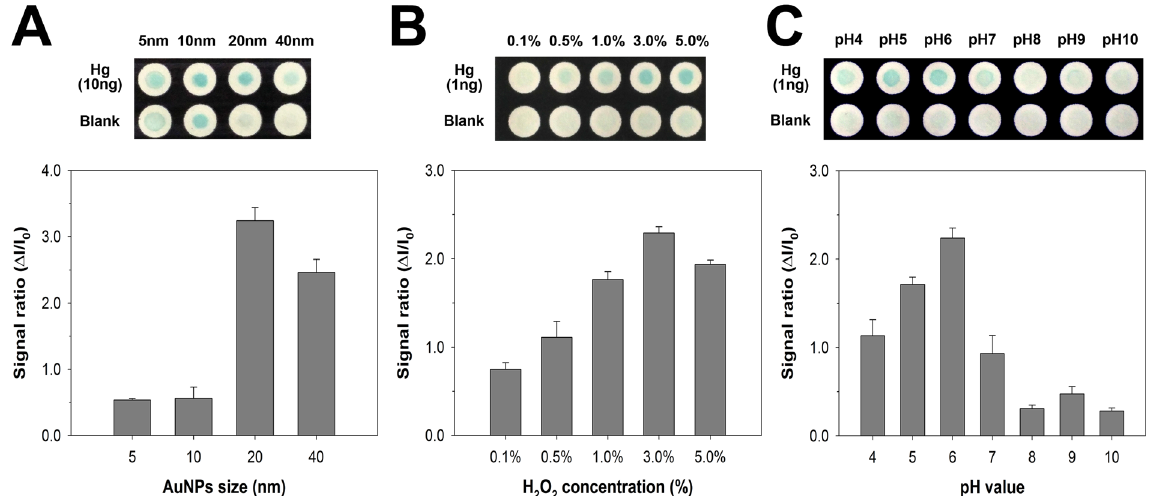
Figure 2. Effect of ( A ) the size of AuNPs, ( B ) the concentration of H 2 O 2 , and ( C ) the pH value on the colorimetric response in the absence and presence of Hg 2 + ions. Error bars indicate the standard deviation (SD) of three independent